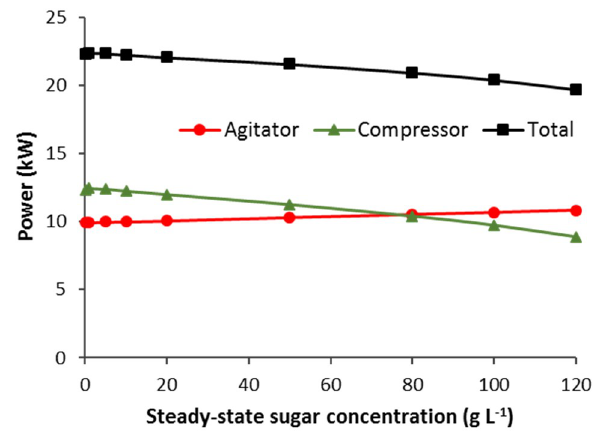
Figure 8. Minimum total electrical power required (and corresponding compressor and agitator power requirements) at each CSTB steady-state sugar concentration value [steady-state oxygen concentration is 2 mg · L − 1 ].